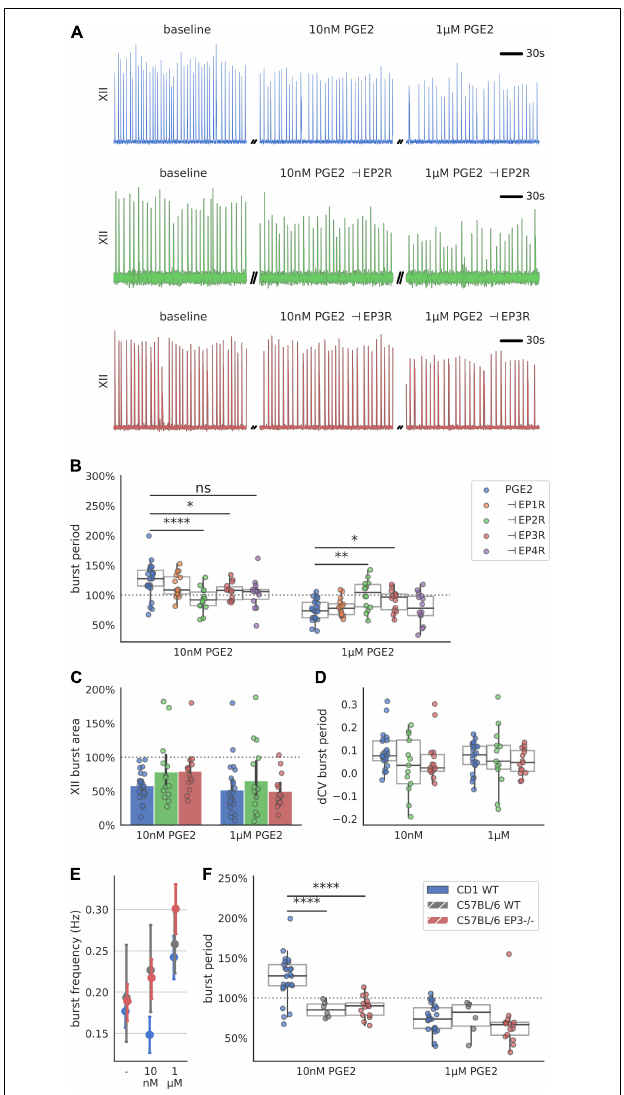
FIGURE 3 | Respiration-related XII motor nucleus output after incubation with a prostanoid antagonist and exposure to 10 nM and 1 µ M PGE2. (A) Examples of integrated hypoglossal motor output (XII) of slices exposed to PGE2 with and without inhibiting EP2R (500 nM PF-04418948) and EP3R (40 nM DG-041) (150 s shown per condition). (B) Inhibition of EP2R leads to a decrease of burst period at 10 nM (–8% below baseline, –33% below uninhibited controls, p < 0.00001 vs. controls) and no change at 1 µ M ( ± 0% above baseline, +25% above uninhibited controls, p < 0.01 vs. controls). Inhibition of EP3R leads to an increase at 10 nM (+7% above baseline, –18% below uninhibited controls, p < 0.05 vs. controls) and decrease at 1 µ M (–9% below baseline, +16% above uninhibited controls, p < 0.05). (C) Antagonizing either EP2R or EP3R prior to exposure to PGE2 does not change XII burst area. (D) Change in CV of the burst period after exposure to PGE2 is not changed with prior incubation in EP2R or EP3R antagonist. (E) CD-1 mice respond with biphasic change in XII burst frequency to PGE2, while C57BL/6 WT and EP3 knock out mice only show an increase in their frequency across the concentration range tested (F) Change in XII burst period of CD-1 WT mice in response to 10 nM PGE2 is different from C57BL/6 WT (–14% below baseline, –39% below CD-1 control, p < 0.0001 vs. control) and Ptger3-/- knockouts (–11% below baseline, –36% below CD-1 control, p < 0.0001 vs. control), but not at 1 µ M PGE2 ( ∗ p < 0.05, ∗∗ p < 0.01, ∗∗∗∗ p <